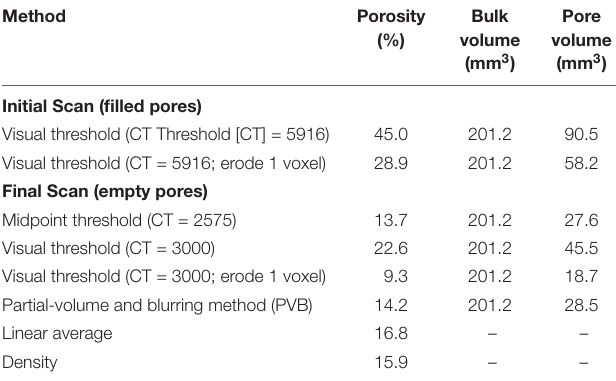
TABLE 1 | XCT-based and physical porosity measurements for sample